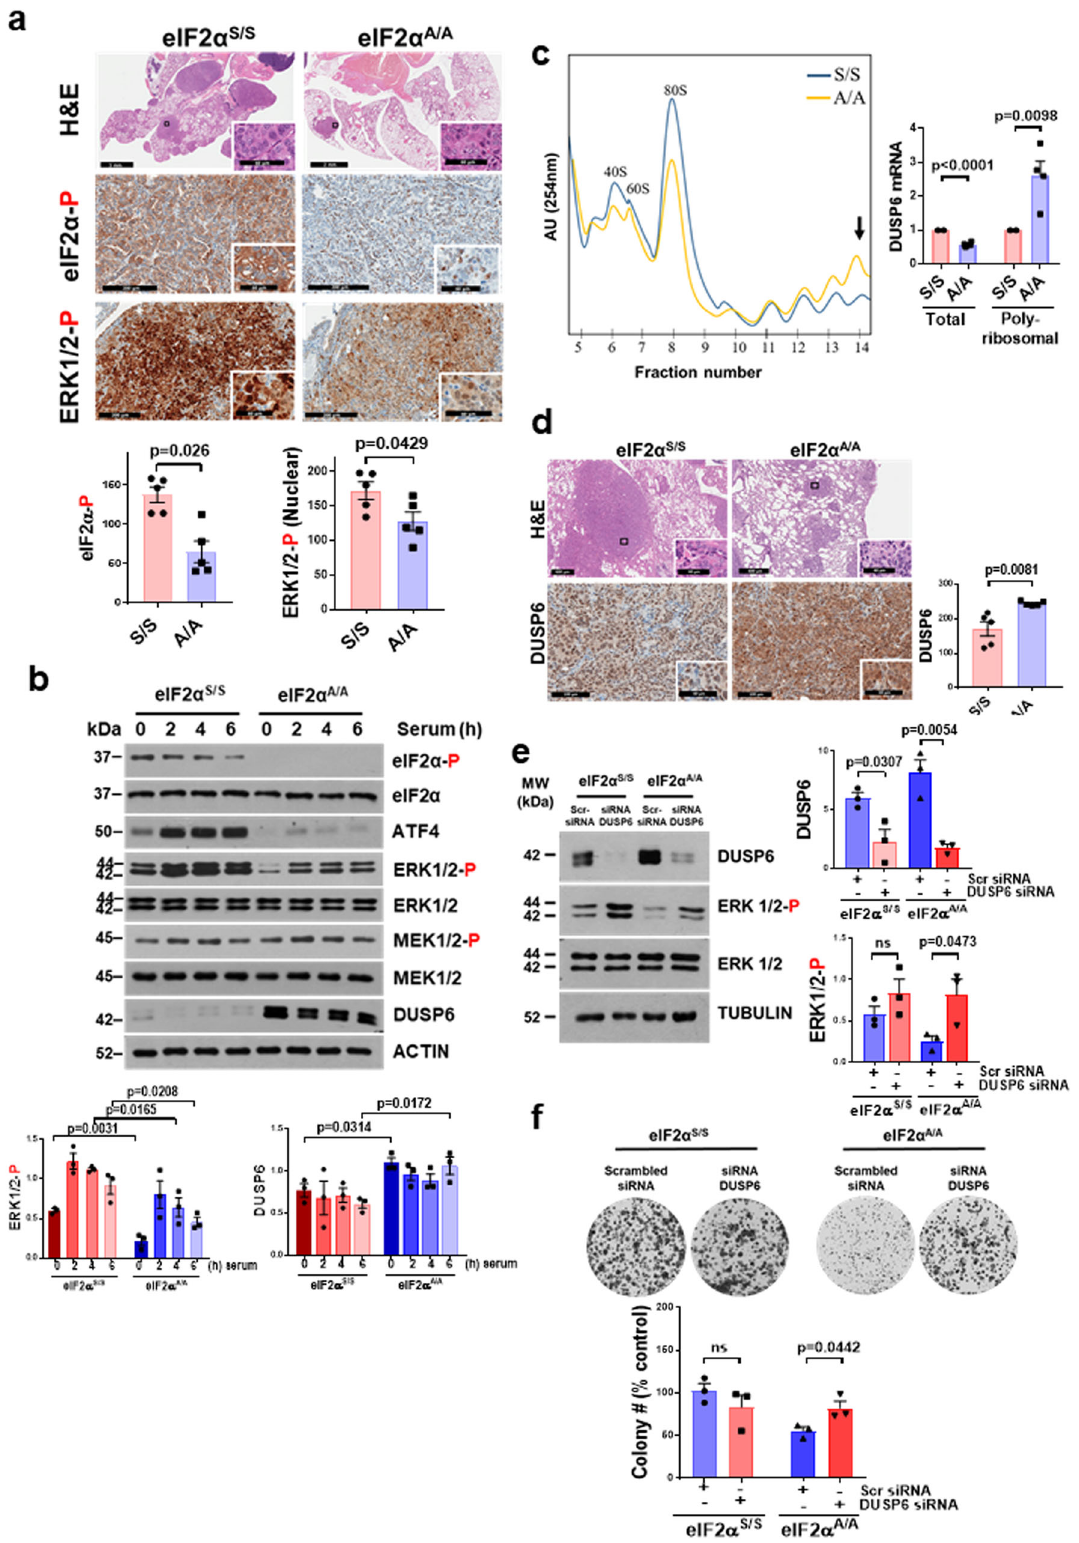
in lung tumor size after 24 weeks of treatment (Fig. 6e). The difference in tumor growth between vehicle control- and ISRIB- treated mice was maintained at 38 weeks (Fig. 6e), at which time ~50% of vehicle-treated mice were deceased (Fig. 6f). The life span of ISRIB-treated mice was signi fi cantly prolonged compared to vehicle control-treated mice (Fig. 6f). Speci fi cally, all